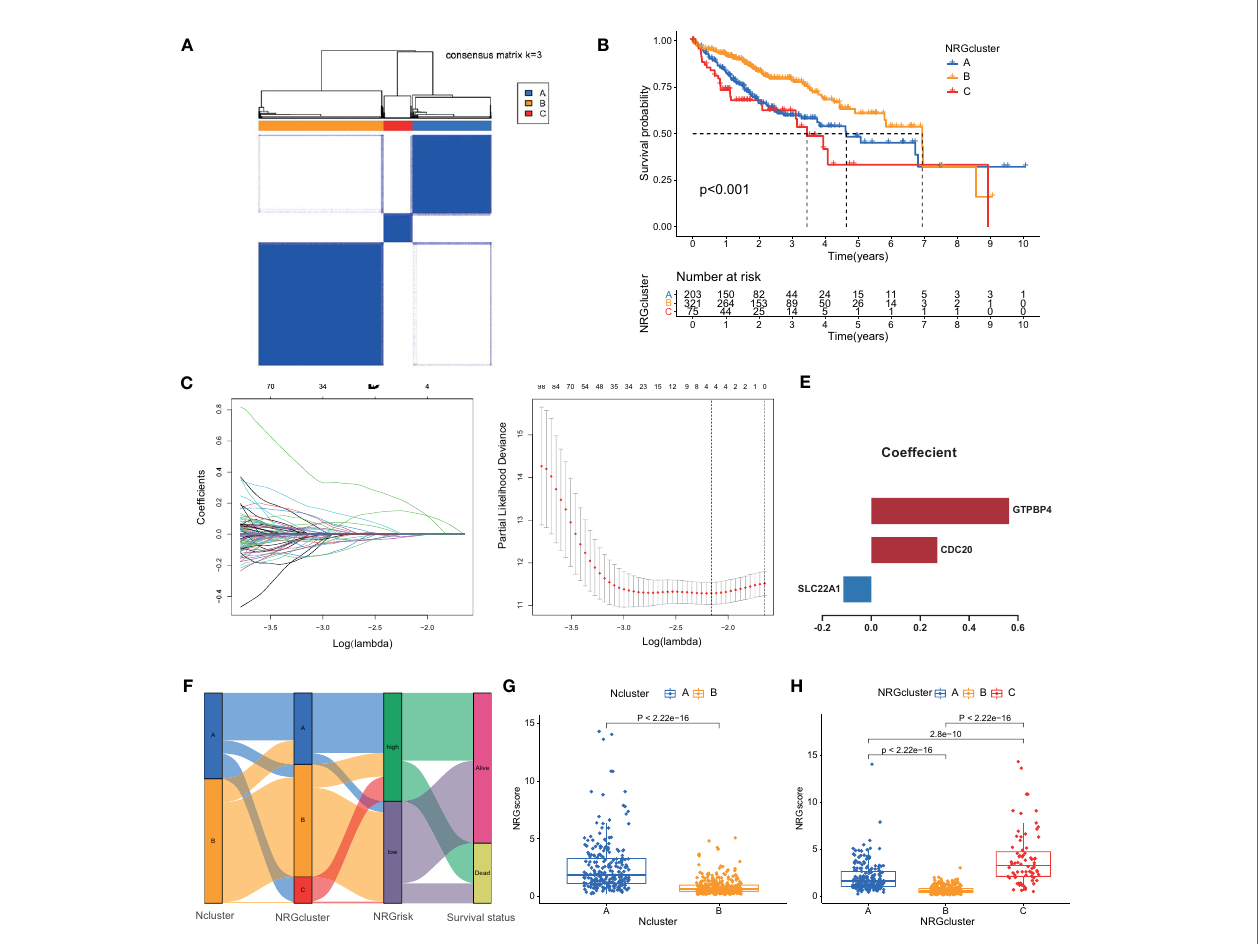
FIGURE 4 | Identi fi cation of necroptosis genomic classi fi cation and construction of NRGscore. (A) Consensus clustering matrix for k =3. (B) Kaplan-Meier curves indicated necroptosis genomic phenotypes were markedly related to the OS of 599 patients in TCGA and ICGC cohorts, of which 203 cases were in gene cluster A, 321 cases in gene cluster B, and 75 cases in gene cluster C. (C) The partial likelihood deviance plot. (D) The Lasso regression coef fi cient pro fi les. (E) Coef fi cient of three core necroptosis-related DEGs. (F) The alluvial diagram exhibited the correlation of Ncluster, NRGcluster, NRGscore, and survival status. (G) Differences in NRGscore between two Nclusters in TCGA and ICGC cohorts. The upper and lower ends of the boxes represented the interquartile range of values. The lines in the boxes represented median value, and dots showed outliers. (H) Differences in NRGscore among three NRGclusters in TCGC and ICGC cohorts. P<0.05 *; P<0.01**; P<0.001***. NRGscore, necroptosis-related gene score; OS, overall survival; TCGA, the cancer genome atlas; ICGC, international cancer genome consortium; Lasso, least absolute shrinkage and selection operator; DEGs, differentially expressed genes; Ncluster, necroptosis cluster; NRGclusters, necroptosis- related genes